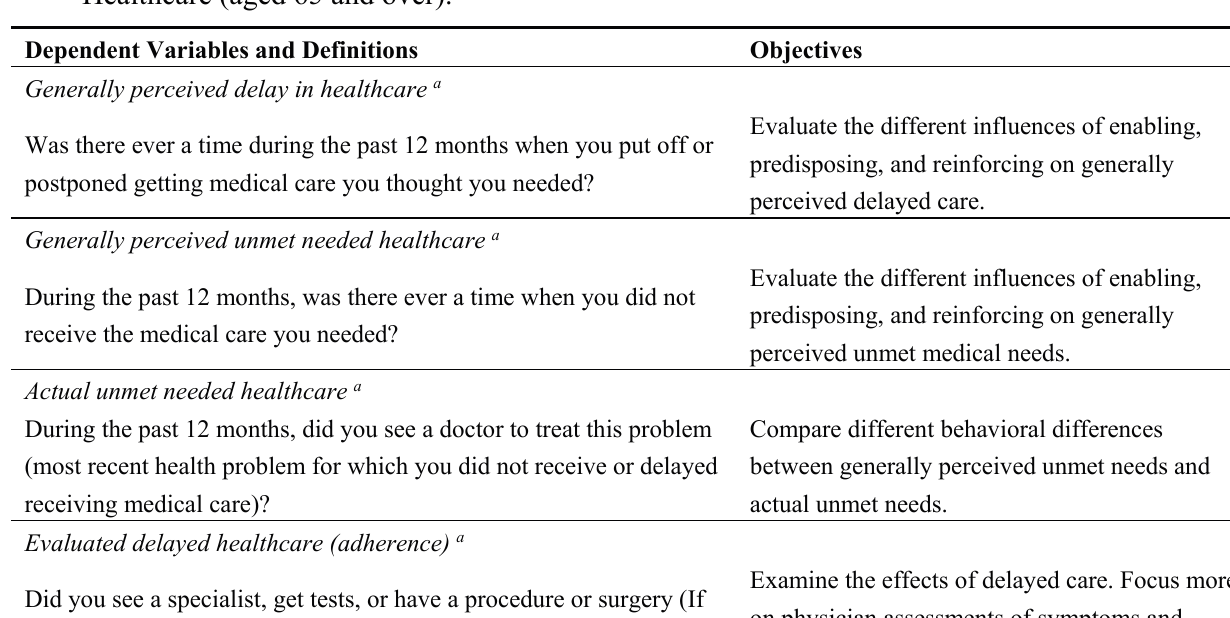
Table 1. Definitions and Characteristics of Delayed Healthcare, and Unmet Needed Healthcare (aged 65 and